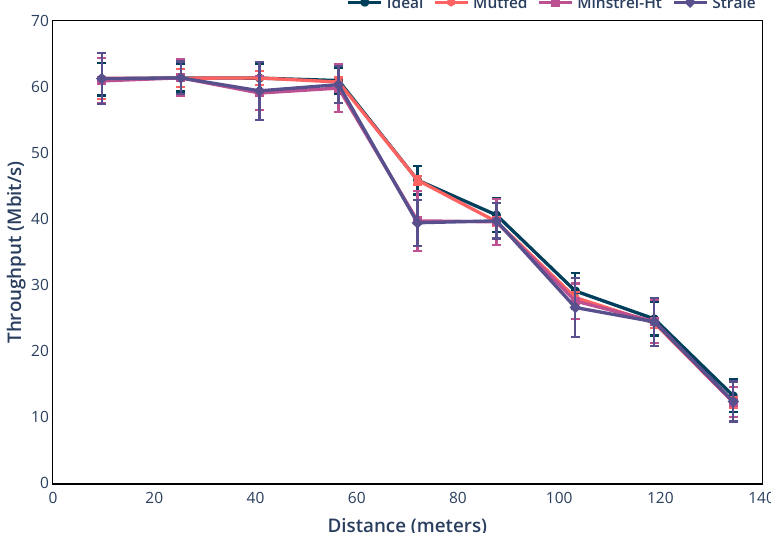
Figure 1. Throughput of a station moving away from an access point at a speed of 6